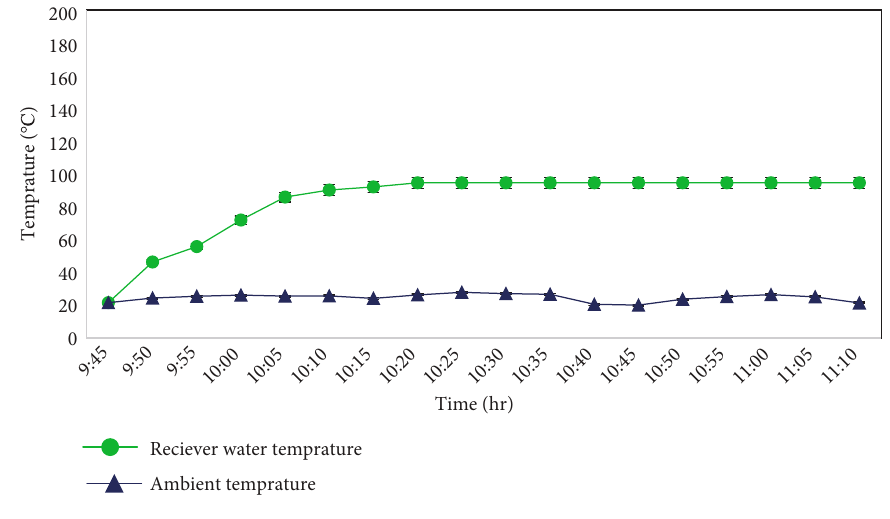
Figure 6: Receiver water temperature and ambient temperature.